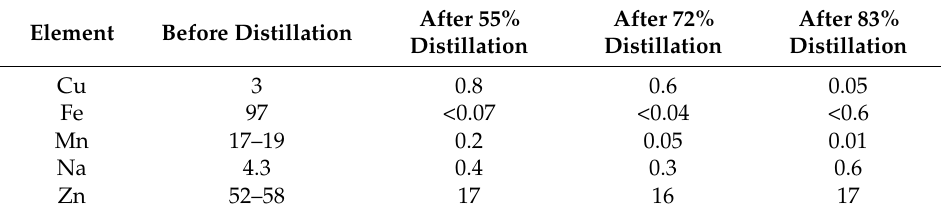
Table 3. Impurity concentration (in ppm) in samples with varying distillation quantity [35]. After 55% After Element Before Distillation